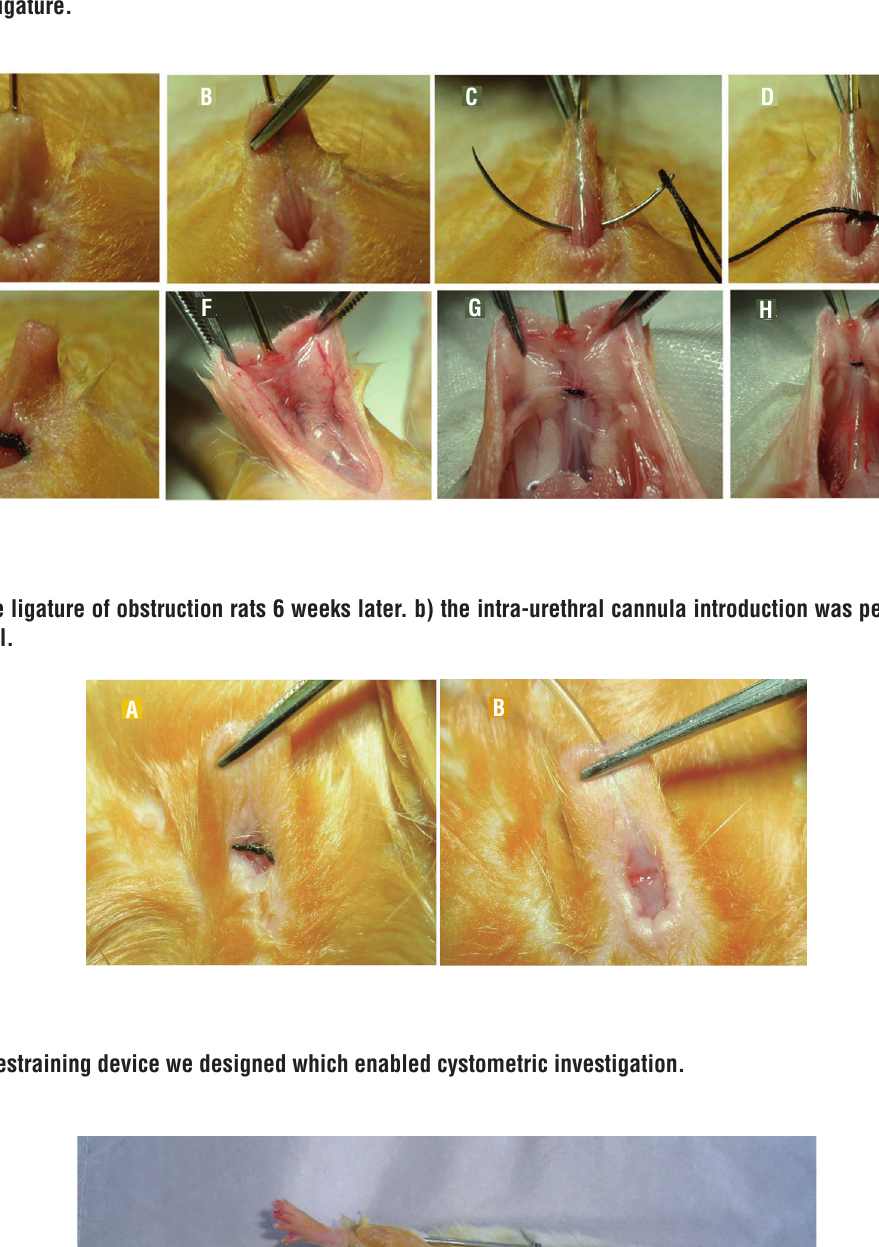
Figure 2 - a, b, c, d and e: the surgical procedures for obstruction rats. A, B and C: the dissection of an obstruction rat to identify the location of ligature.